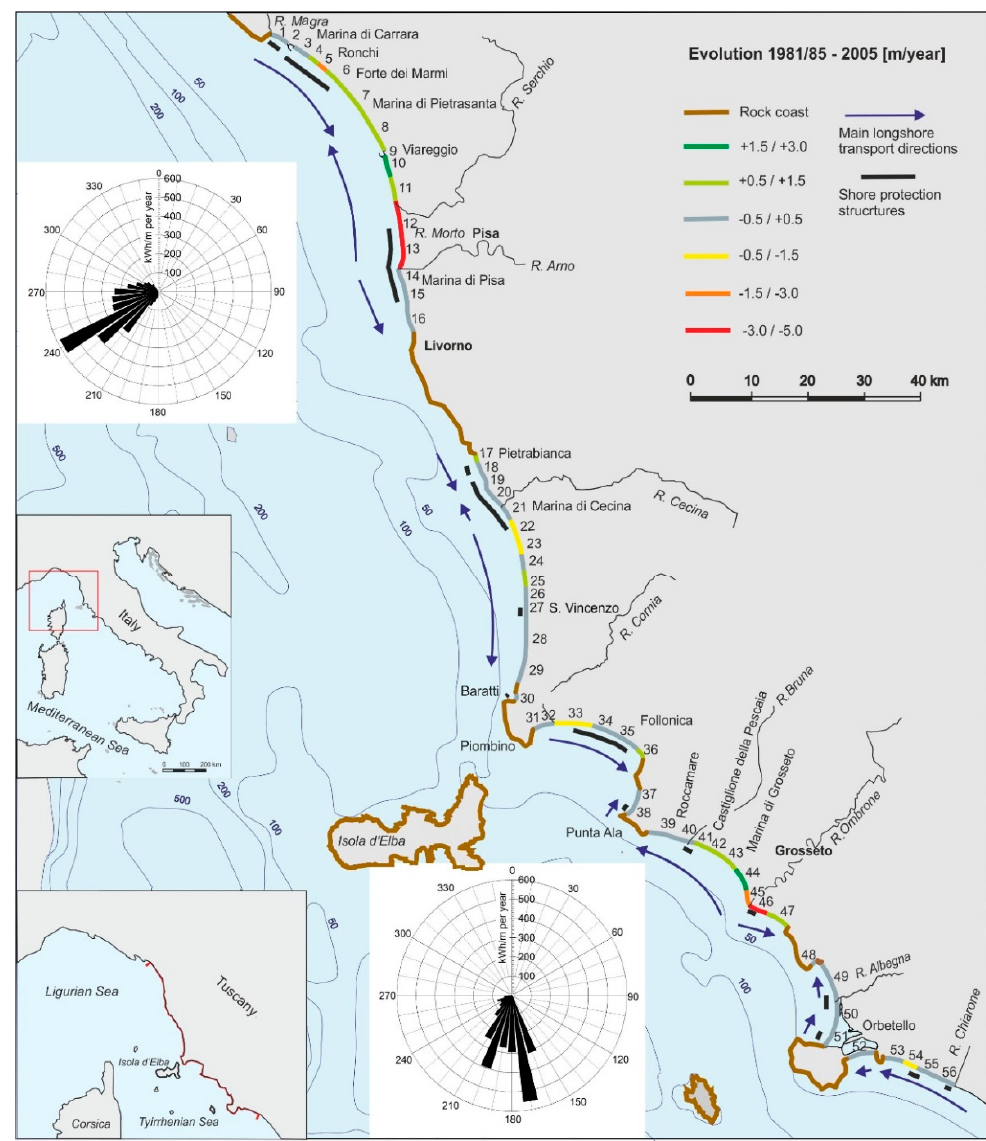
Figure 1. Shoreline evolution along the Tuscan coast from 1981–1985 to 2005; the sectors into which the coast has been divided for the present study are also shown. In Appendix A, the time interval for each coastal sector is presented. Wave energy (KWh/m) directional distribution roses obtained from KNMI data are also reported.